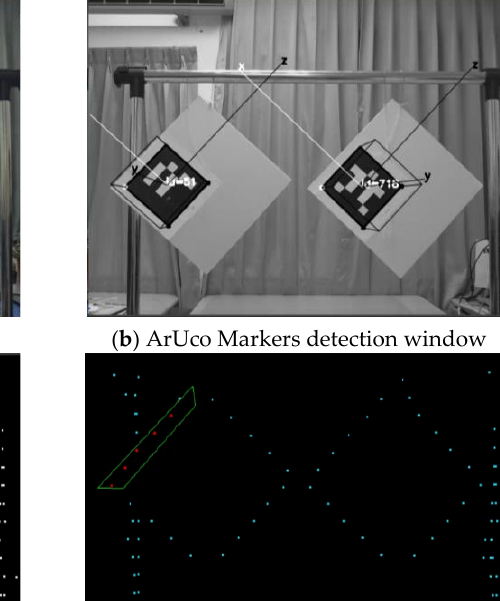
Figure 13. Results of using three calibration plates. 4.3. Combining the Instant Point Cloud and Image After the LiDAR and the camera are jointly calibrated, the transformation matrix be- tween the two can be obtained. The 3D point cloud of the LiDAR can be instantly projected onto the 2D image of the camera using the ROS Package designed in our research. Figures 14 and 15 show the projection results using the transformation matrix obtained via the joint calibration. The color of the points in the figures represents the distances. The nearer a point, the redder it becomes, and the further away, the greener it becomes. In Figure 15, three calibration plates are used to obtain the transformation matrix. Compared with Fig- ure 14, the deviation of the projection of Figure 15 is more obvious. Therefore, points can- not be accurately projected onto the correct position. Figure 14. Projection result of using two calibration boards.